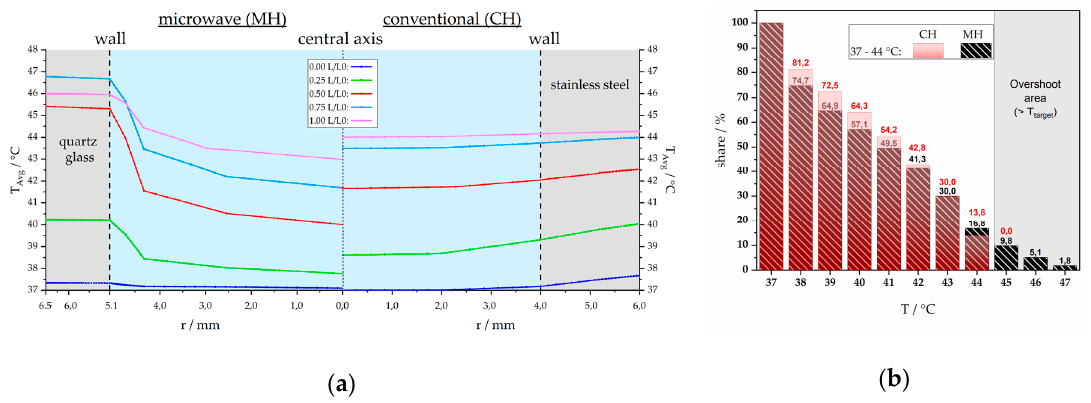
Figure 12. Simulated radial temperature profile and percentage of the respective temperature range: ( a ) fluid medium (blue field) for microwave (left, MH) and conventional (right, CH) heating at five normalized positions (L / L0) along the heating device. Process conditions in this example were T target = 44 °C and 𝑉(cid:4662) (cid:3040) = 2 mL/s at P MW = 100 W, respectively T W = 48.5 °C. ( b ) Percentage of the respective temperature range with conventional heating (filled bars and percentage rates in red, CH) or microwave heating (dashed bars and percentage rates in black, MH). Additional information about the heating systems used for the experiments is provided in Sections 4.1 and 4.2.